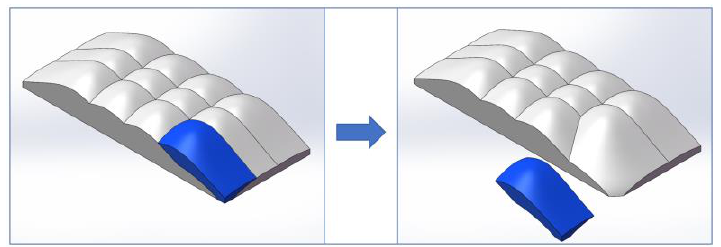
Figure 8. The stacking model built by SolidWorks.